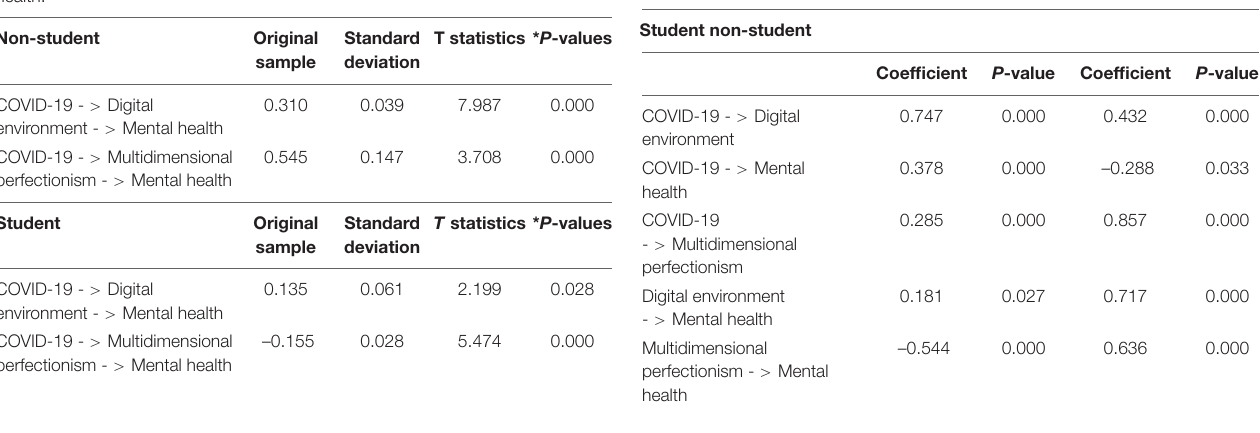
TABLE 6 | COVID-19’s indirect effects on non-students and students’ mental